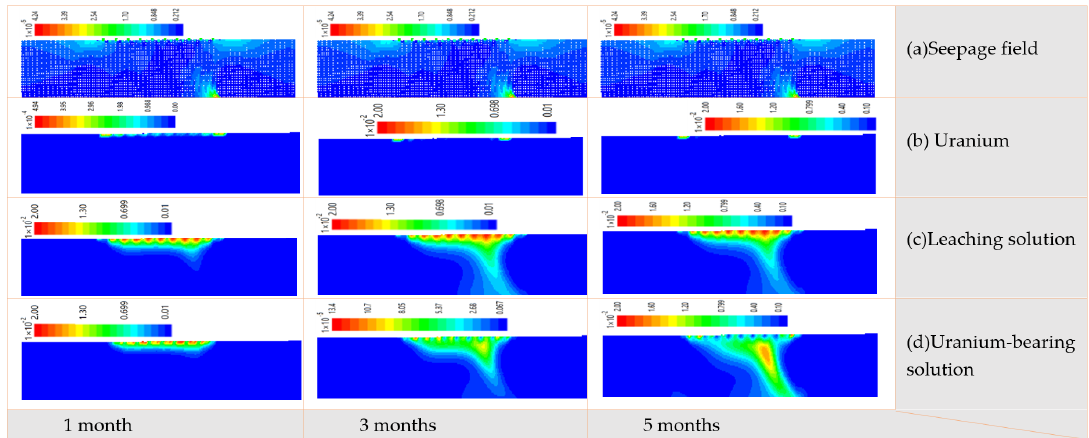
Figure 7. Multifield coupling evolution in the stope ventilation, (a) Seepage field; (b) Uranium; (c) Leaching solution; (d) Uranium-bearing solution.